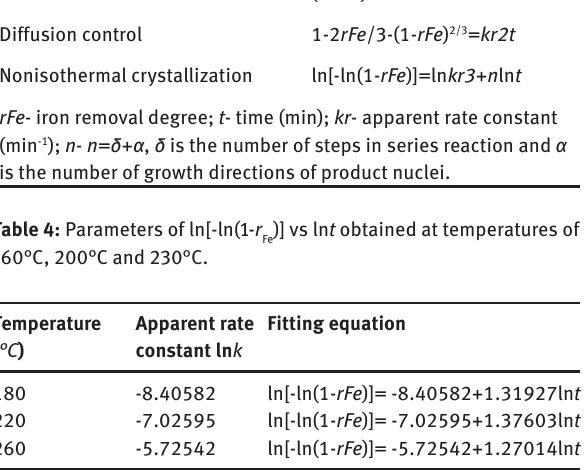
Table 3: Integrated rate equations for the solid-solid reaction. Rate-controlling step